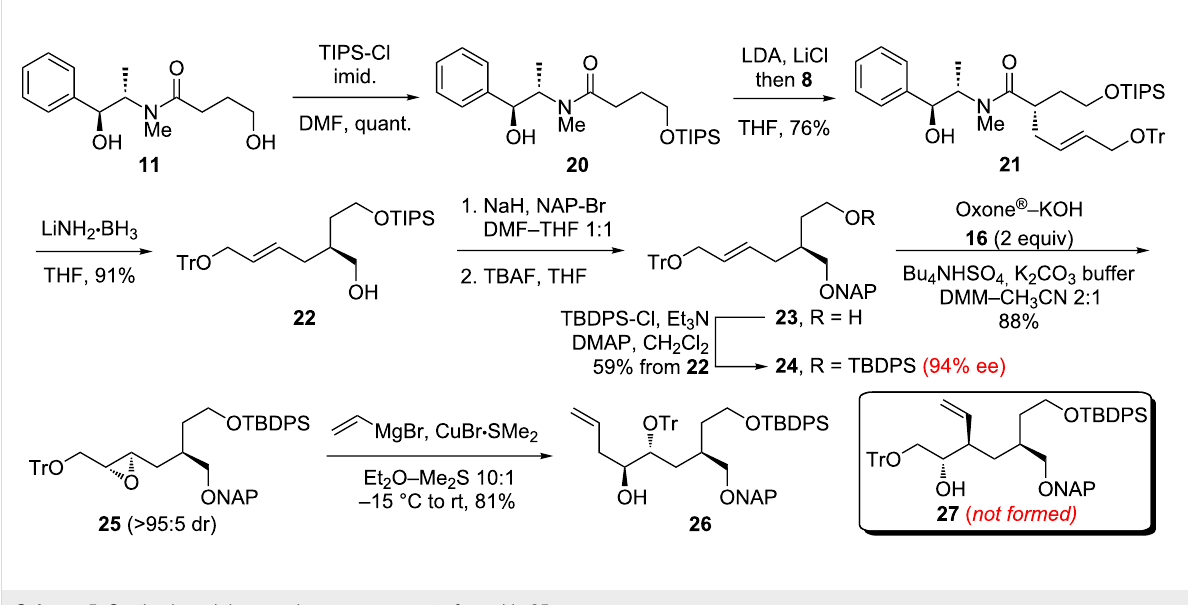
Scheme 5: Synthesis and ring-opening rearrangement of epoxide 25 .